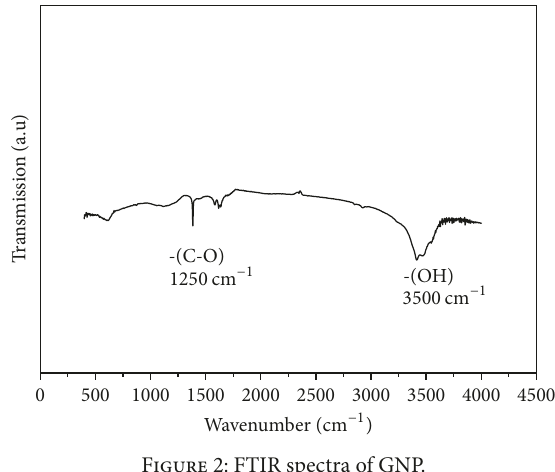
Figure 2: FTIR spectra of GNP.